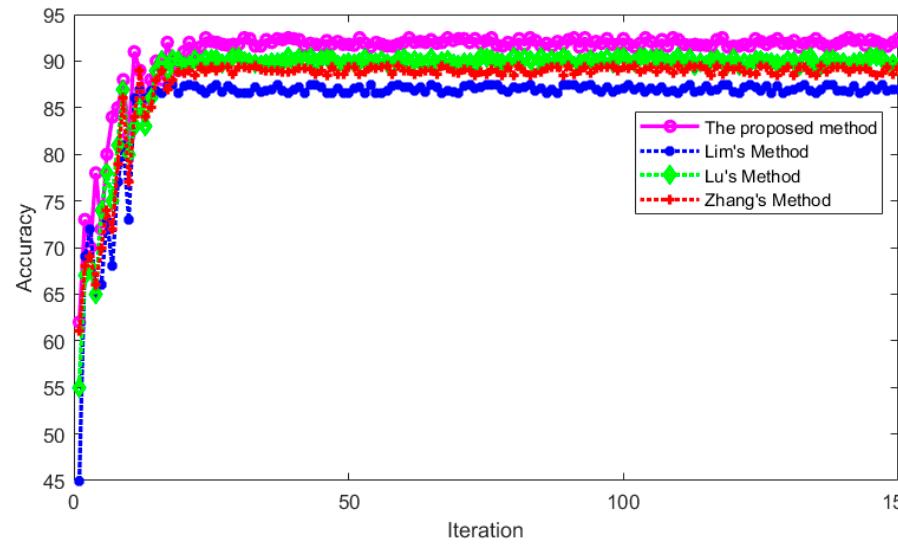
Figure 21. The recognition accuracy for four methods in test set. Table 5. The average recognition accuracy of these methods in training set.